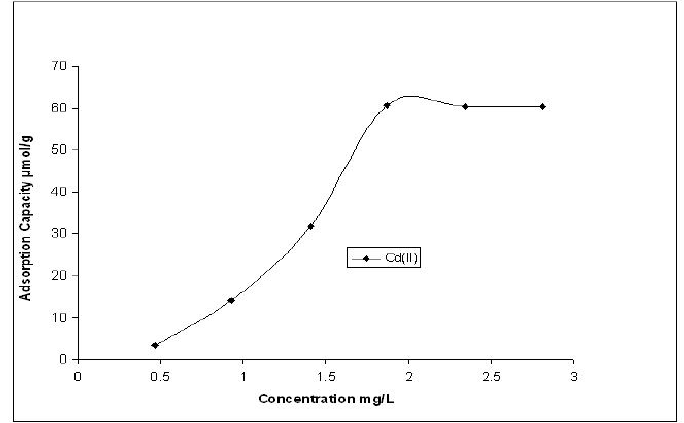
Figure 8. Adsorption capacity of Cd(II) on nanometer SiO